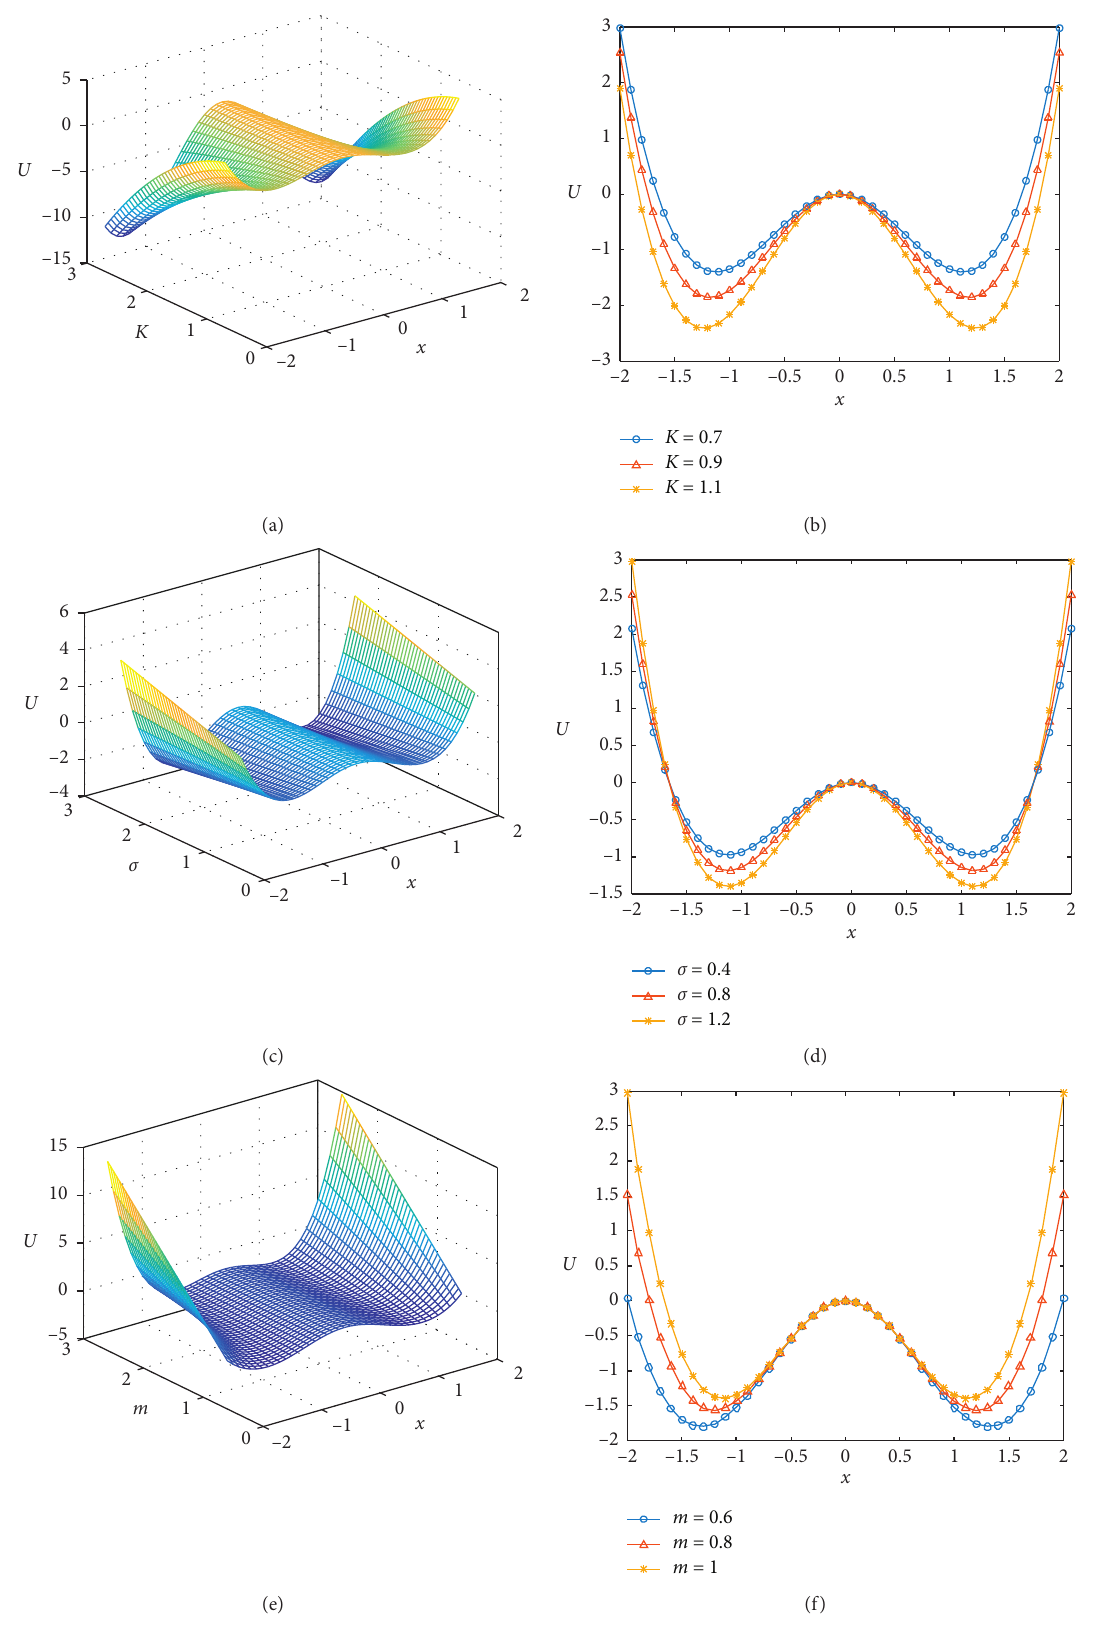
Figure 2: Curve of potential function with different parameters: (a) when m � 1 and σ � 1.2, the relationship between U , x , and K ; (b) detailed relationship diagram between U and K ; (c) when m � 1 and K � 0.7, the relationship between U , x , and σ ; (d) detailed relationship diagram between U and σ ; (e) when K � 0.7 and σ � 1.2, the relationship between U , x , and m ; (f) detailed relationship diagram between U and m